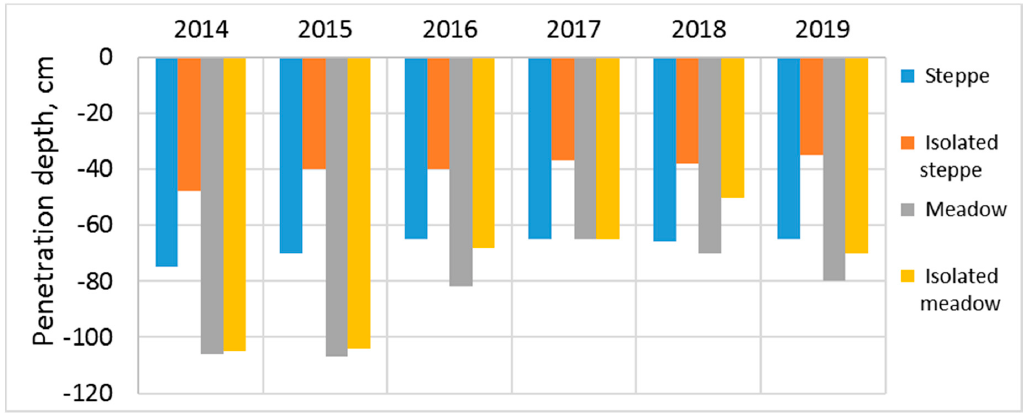
Figure 9. The change in the penetration depth of active temperatures (above 10 °C). The F-ratio value is 22.45181. The p -value is < 0.00001. The result is significant at p < 0.05.